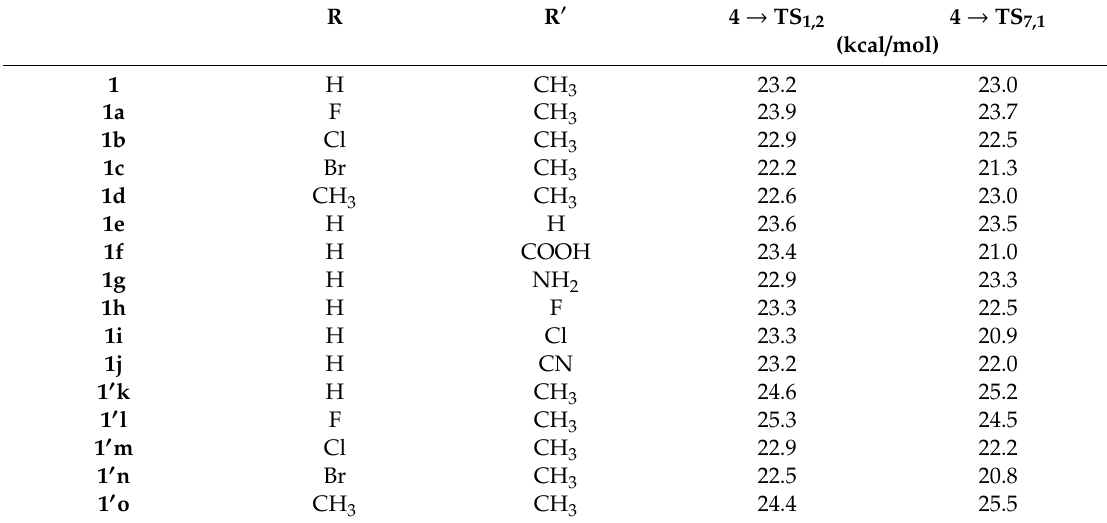
Figure 4. Proposed SCS nickel pincer complexes with different substituents at R and R’. Table 1. Relative free energies of 4 → TS 1,2 and 4 → TS 7,1 with different functional groups at R and R’ in the SCS nickel pincer complexes.